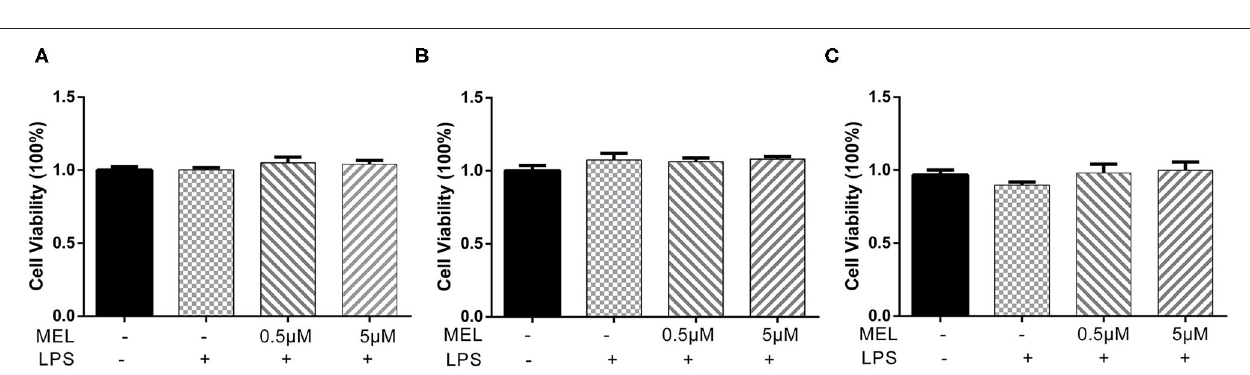
FIGURE 3 | The effect of meloxicam on the viability of primary bovine endometrial epithelial cells stimulated with lipopolysaccharide. LPS, lipopolysaccharide; MEL, meloxicam. The cells were co-treated with MEL (0.5 and 5 µ M) and LPS (10 µ g/ml) for 24 (A) , 48 (B) , and 72h (C) . All data were presented as means ± SEM ( n =